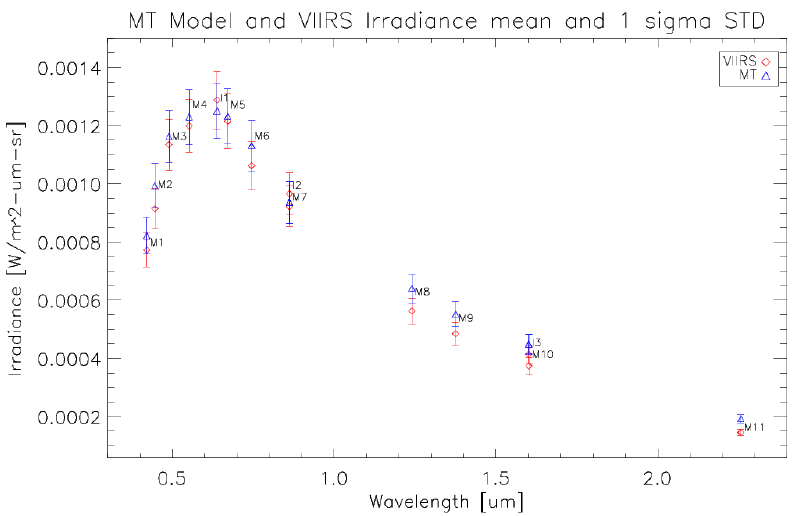
Figure 8. Lifetime mean and 1 sigma range of the Miller and Turner (MT) model and observed lunar